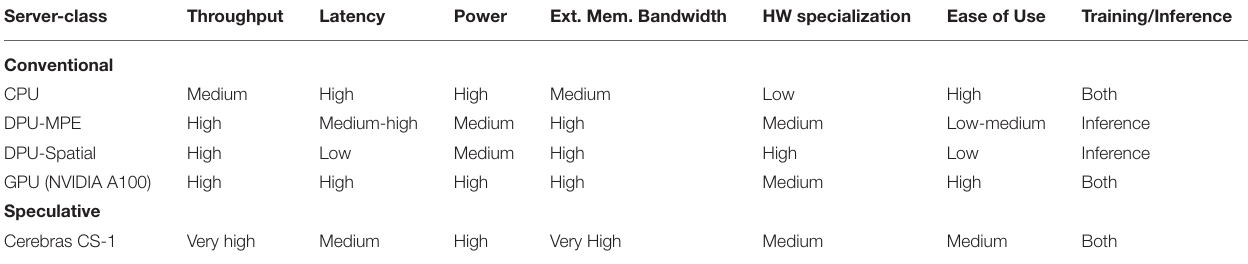
TABLE 4 | Characterization of types of hardware based on important metrics.